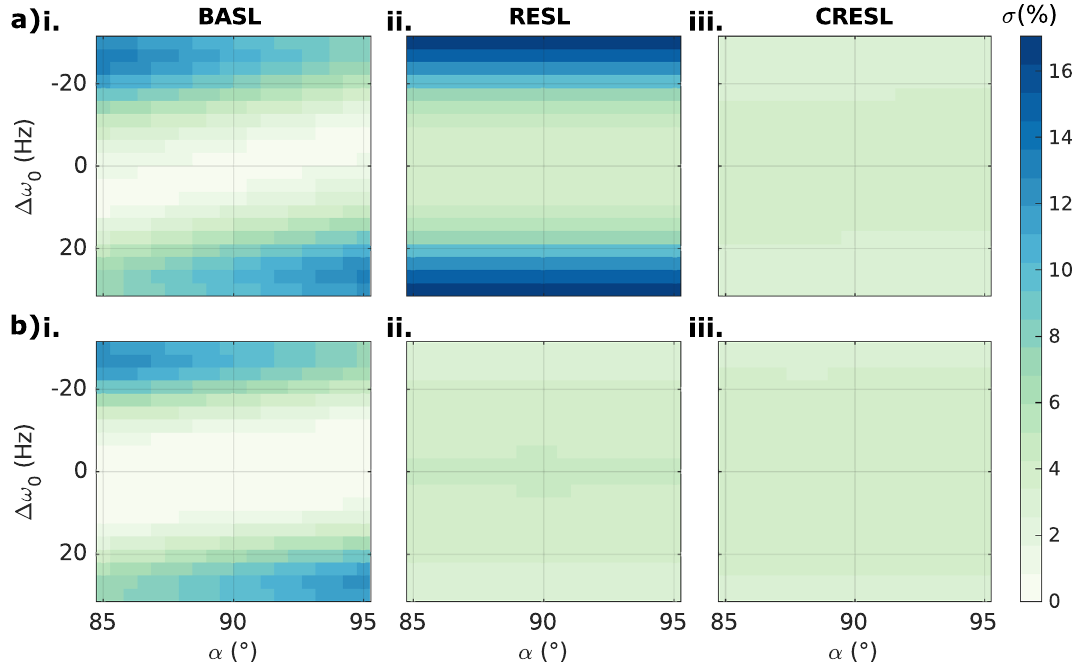
Figure 4. Simulated contrast variation map (signal standard deviation σ ) as a function of the excitation angle α (°) and the frequency offset �ω 0 (Hz) in resonance condition, ω NC = ω SL = 2 π 90 Hz . ( a ) For T SL = 90 ms: